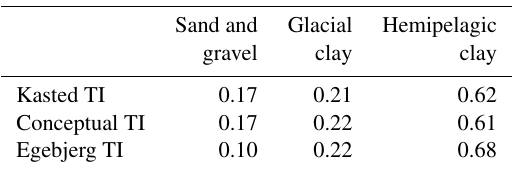
Table 2. The global proportions related to each of the three TIs presented in Fig. 4. Sand and Glacial Hemipelagic gravel clay